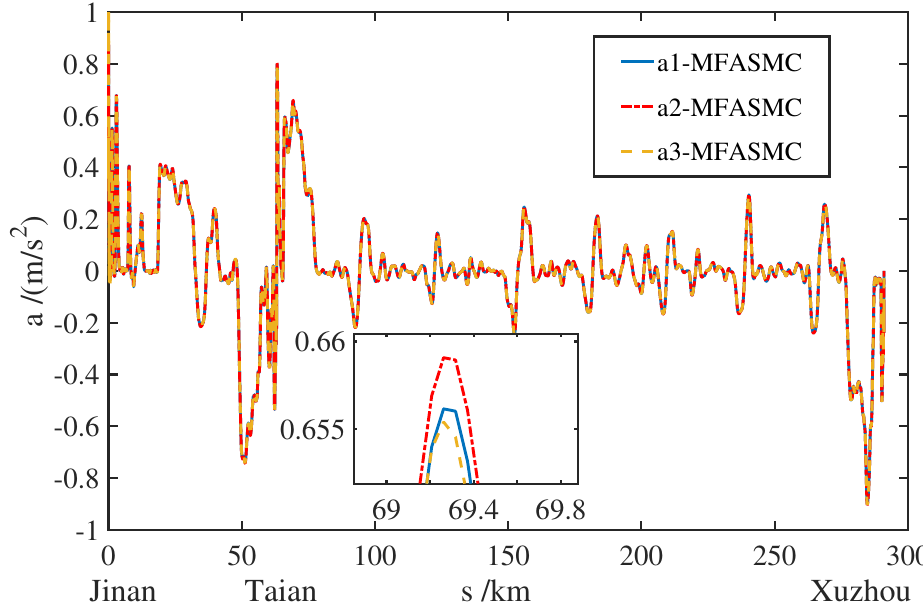
Figure 9. The acceleration distribution of each power unit of